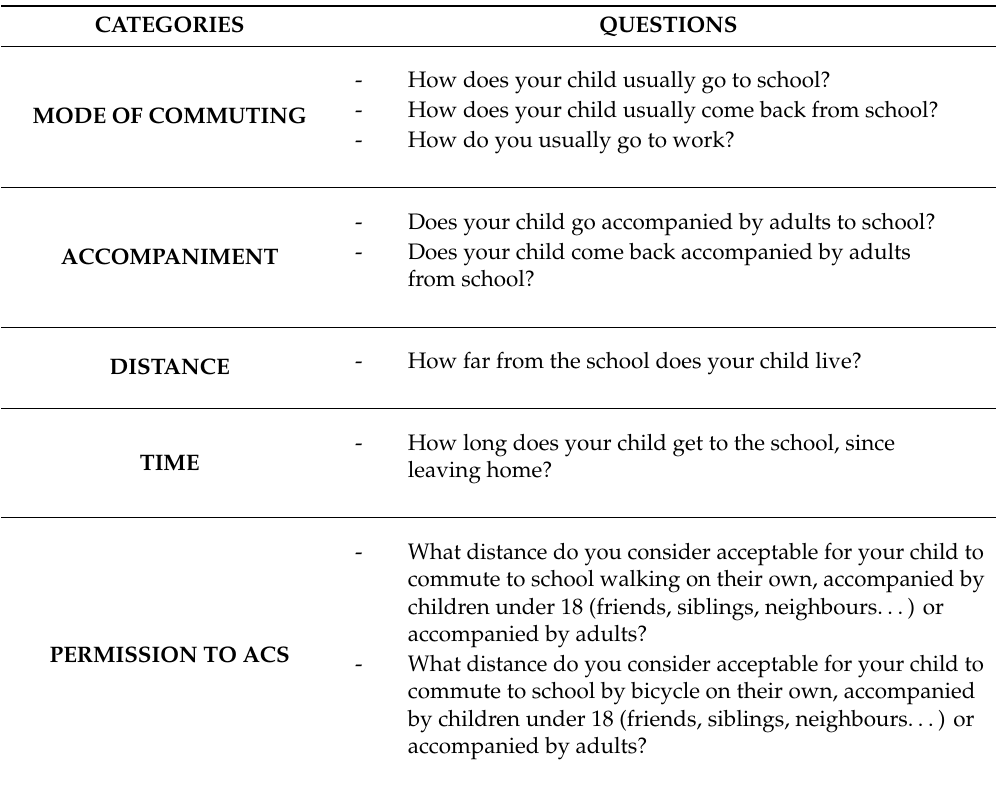
Table 1. Questions of “Family commuting-to-school behaviour” questionnaire classified by